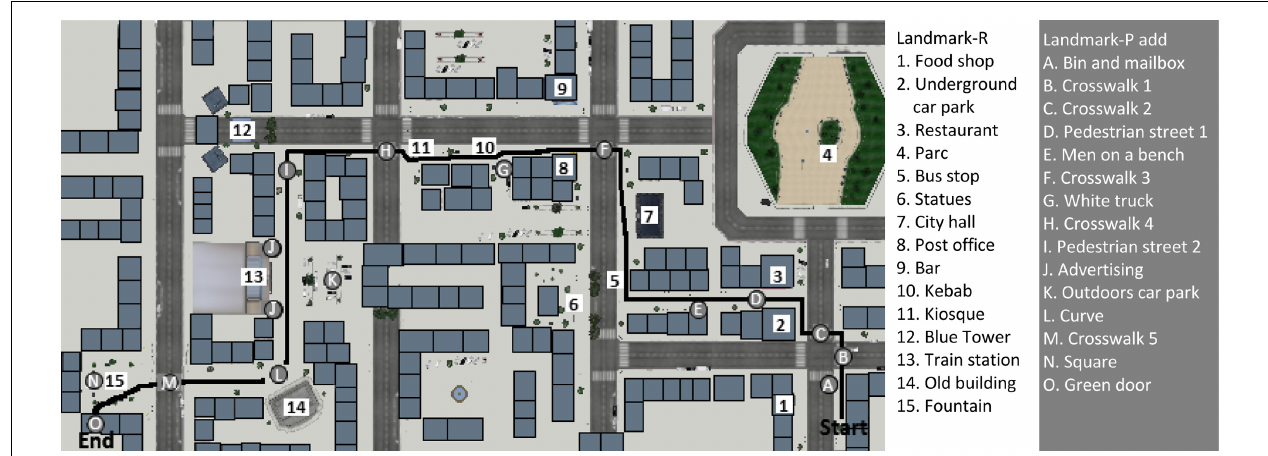
FIGURE 2 | Map of the environment with the route (in black), the landmarks used in the recognition task (numbers in white), and the landmarks additionally mentioned by the participants in their verbal descriptions (letters in grey).